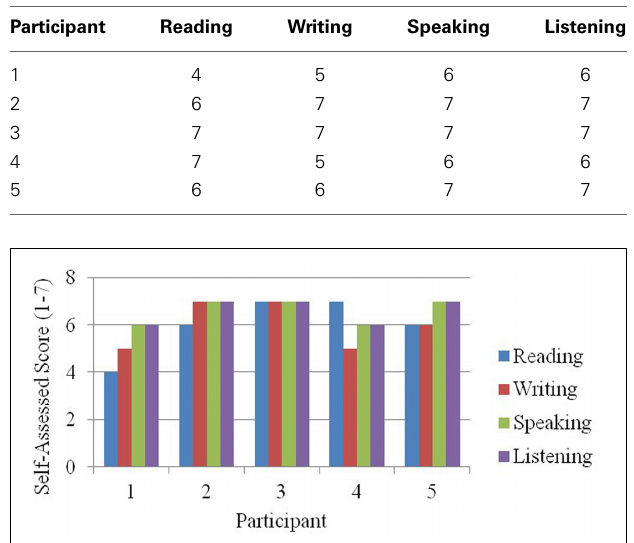
FIGURE 5 | Examples of Facial profiles showing maximum variable size and minimum variable size. Table 2 | Self-assessed reading, writing, speaking and listening abilities for five participants on a 7-point scale.